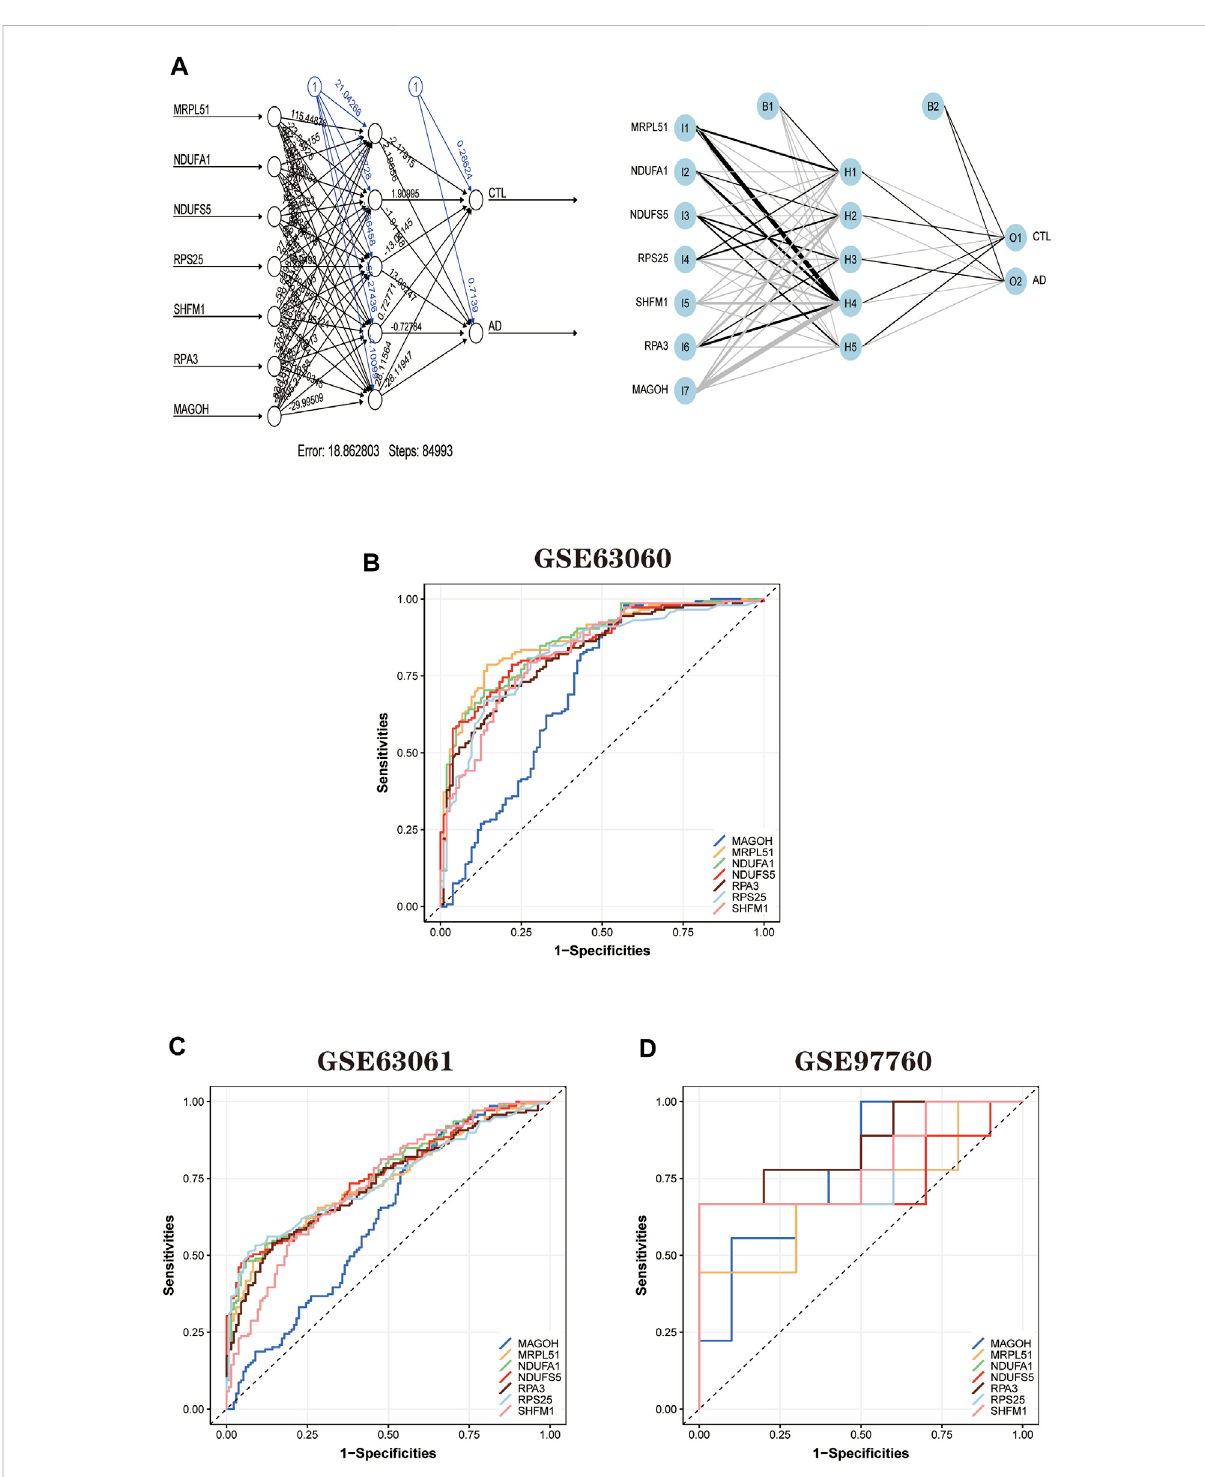
FIGURE 10 Arti fi cial neural network model building and ROC curve validation. (A) Visualization of the arti fi cial neural network model has undergone 84,993 training sessions and contains fi ve hidden layers and two output layers. (B) ROC curves of the training set GSE63060 dataset. (C) The validation results of ROC curves in the validation set GSE63061 dataset. (D) The validation results of ROC curves in the validation set GSE97760 dataset. The different color lines represent different